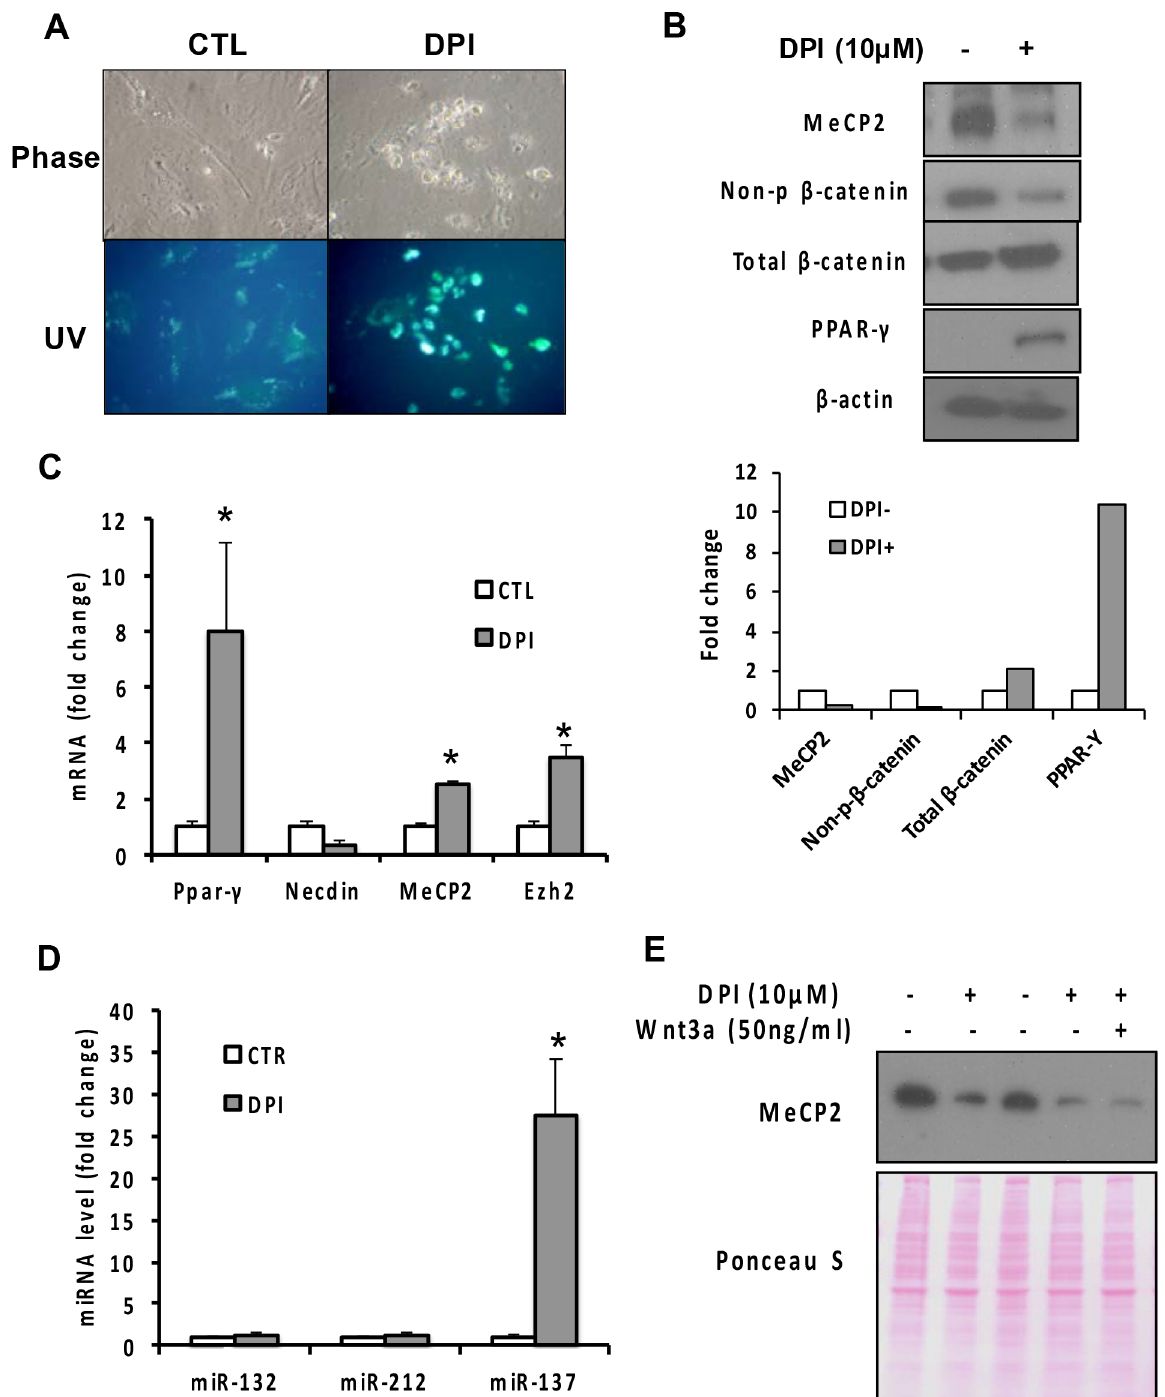
Fig 3. (A) The treatment of culture-activated rat HSC on day 5 with DPI (10 μ M, 24 hr) reverts activated cells to quiescent cells with increased UV-excited vitamin A fluorescence. (B) The DPI treatment reduces MeCP2 and non-phospho(S30/S37/T41)- β -catenin and upregulates PPAR- γ protein in cultured rat HSC. Densitometric results are shown below. (C) The DPI treatment above upregulates Ppar- γ mRNA while suppressing the activation marker Necdin . Mecp2 and Ezh2 mRNA are also increased. * p < 0.05 compared to CTL (vehicle-treated). (D) The DPI treatment has no effects on miR-132 or miR-212 while upregulating miR-137 which was suggested to target Ezh2 . * p < 0.05 compared to CTL. (E) The treatment with Wnt3a does not rescue DPI-mediated suppression of MeCP2 protein. Ponceau S staining shown below demonstrates equal protein loading.